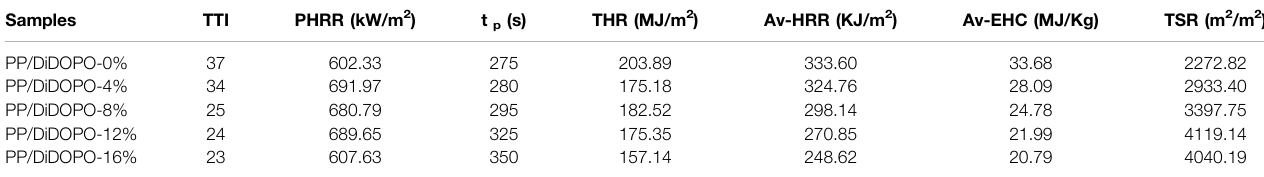
TABLE 2 | CCT data of PP/DiDOPO conjugated fl ame retardant composites. Samples